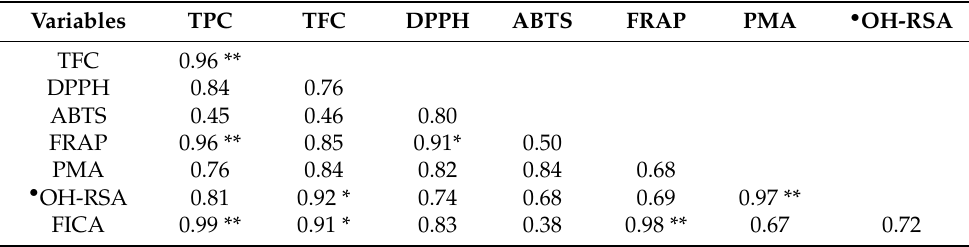
Table 1. Pearson correlation between phenolic contents and antioxidant activities. Variables TPC TFC DPPH ABTS FRAP PMA •